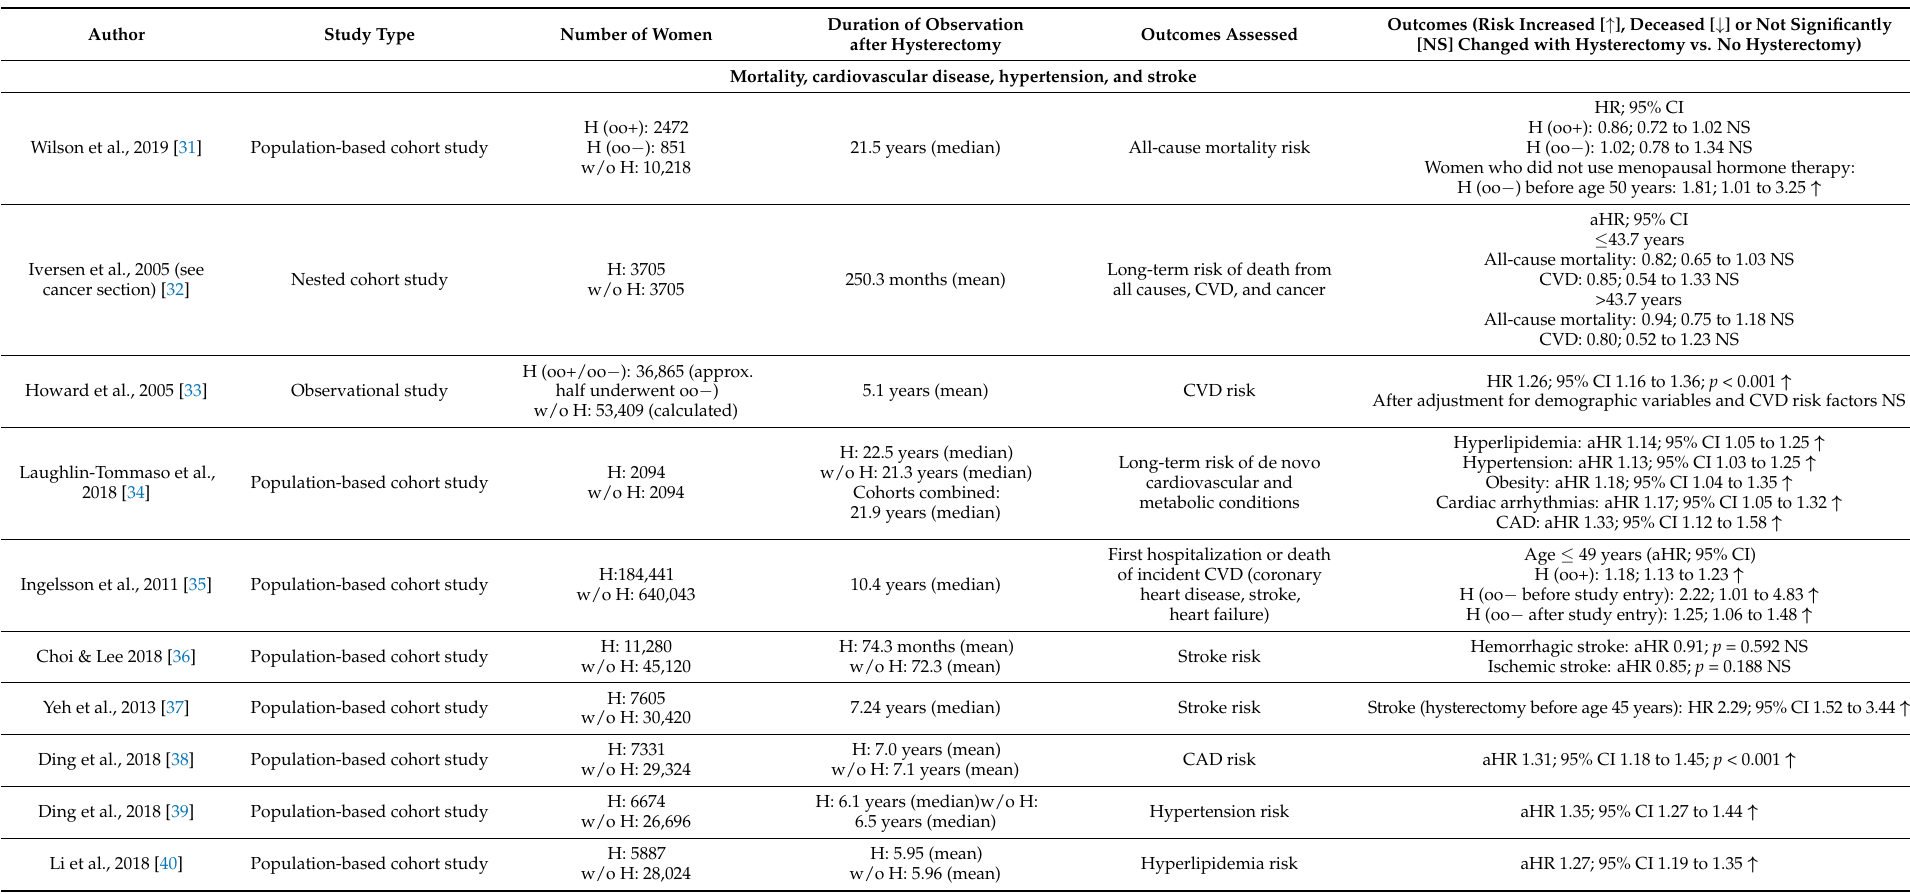
Table 3. Summary of studies investigating long-term outcomes in women with or without